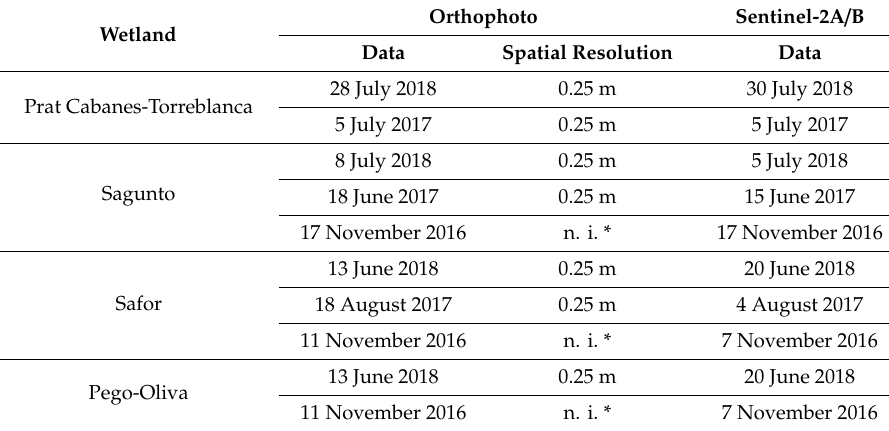
Table 3. List of images used in the study by date.